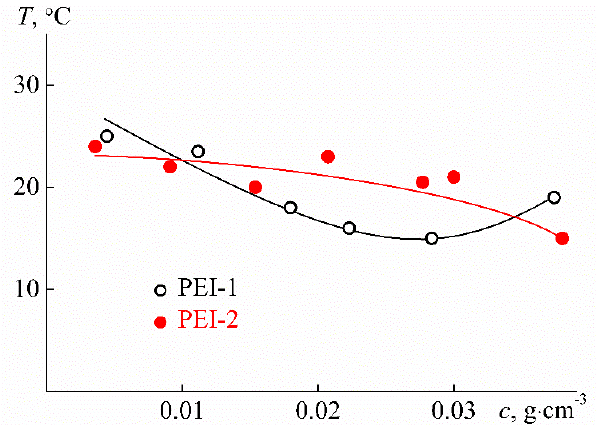
Figure 14. Concentration dependencies of phase separation temperatures T 1 for aqueous solutions of PEI-n.